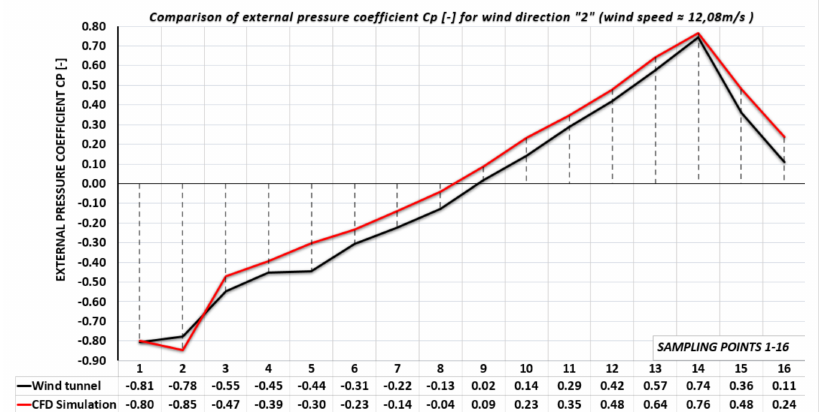
Figure 14. Comparison chart of external pressure coefficient for wind flow direction